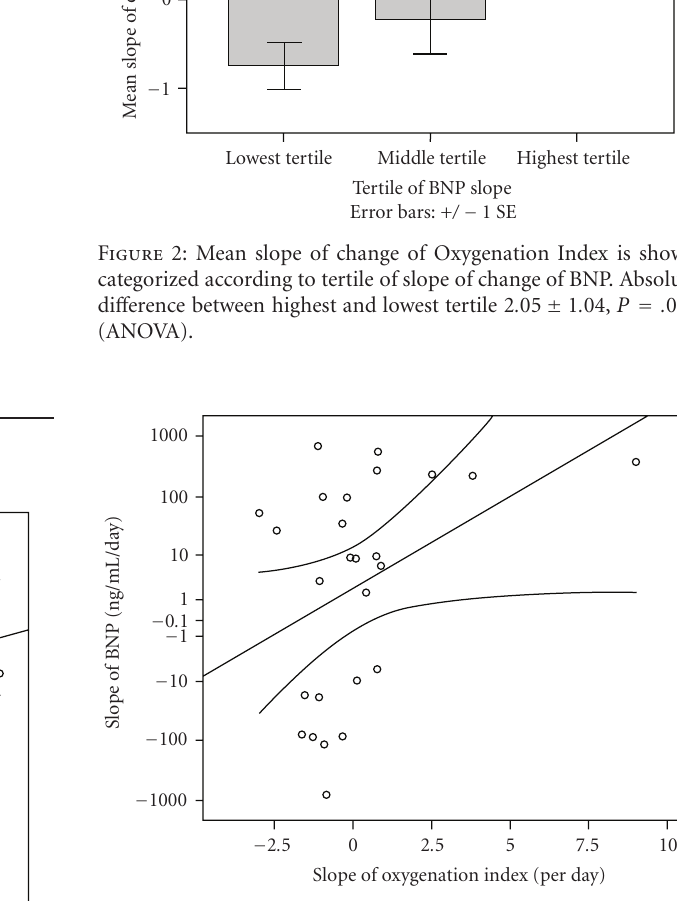
Figure 3: Correlation (with 95% confidence intervals) between slope of BNP and slope of Oxygenation Index ( R = 0 . 40; P = .